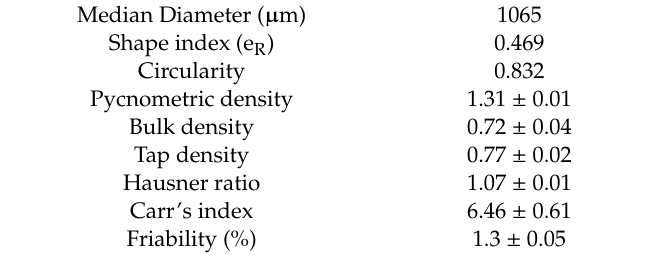
Table 6. Properties of experimental self-emulsifying pellets prepared with 60% w / w sonicated SEDDS emulsion.